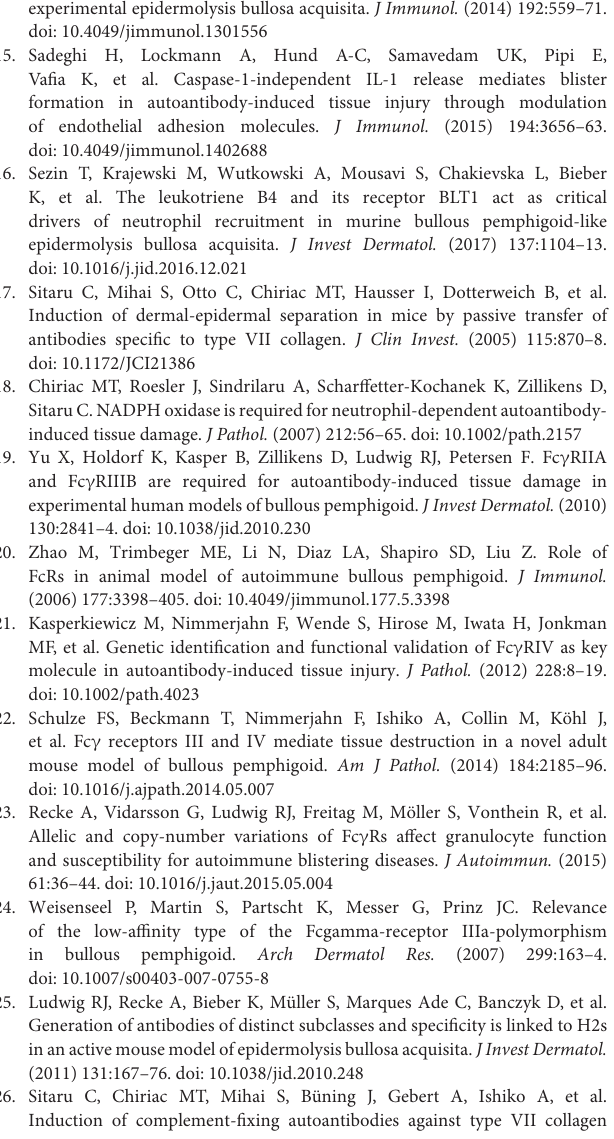
Supplementary Figure 1 | Isotype Control staining of cryosections from B6.s mice. Representative pictures of direct IF staining taken 6 weeks after vWFA2 immunization from B6.s mice. Shown is the direct comparison of IgG Ab isotype control staining (left) vs. IgG antigen-specific staining (right) for (A) Ly6G; (B) MPO; and (C)